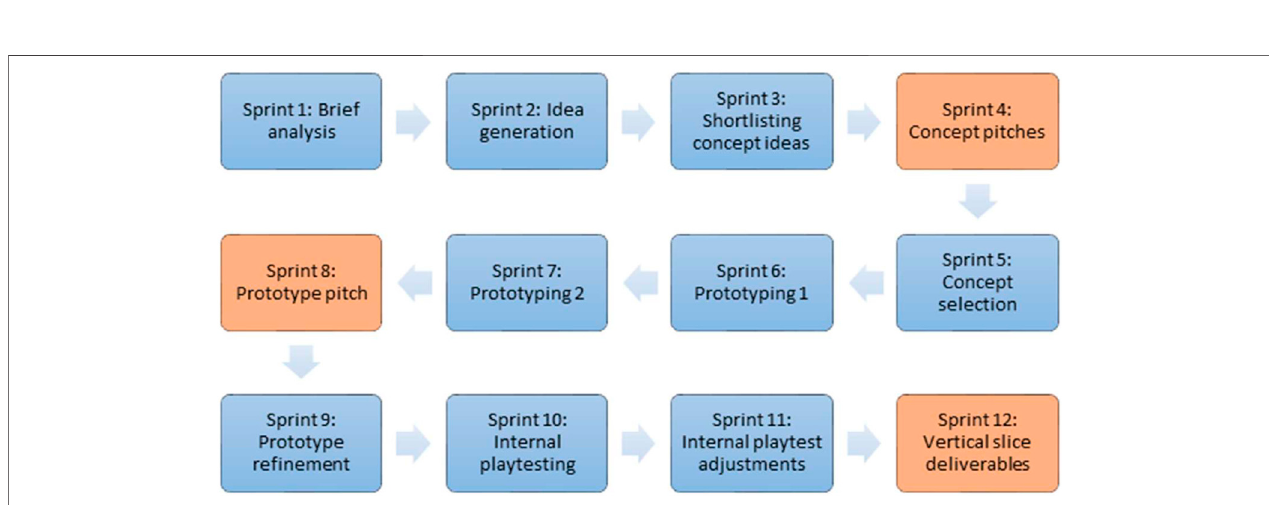
FIGURE 4 | Diagram showing the preproduction phase of game development for this project.